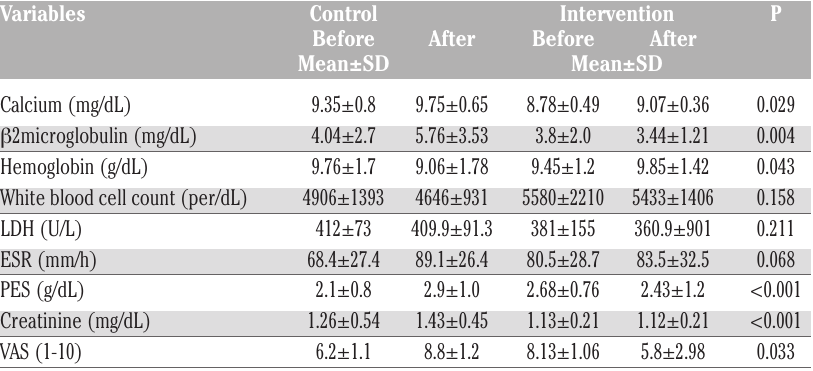
Table 1. Laboratory results of patients in the intervention and in the historical control